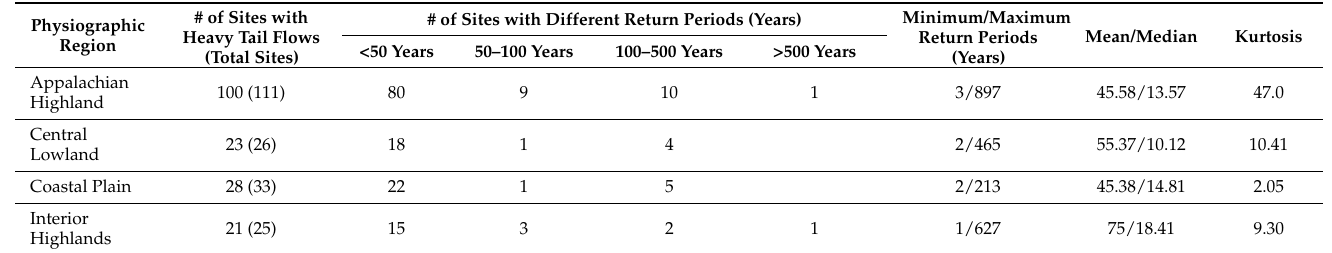
Table 4. Return periods and associated information for heavy tail flows of the bridge collapse sites across different regions.